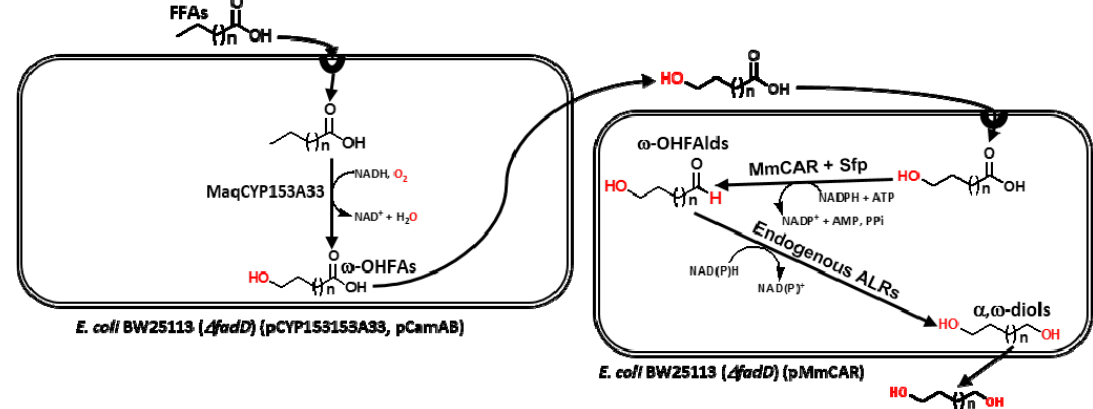
Figure 1. Schematic diagram showing the biosynthesis of medium- to long-chain α , ω -diols (C 8 –C 16 ) from free fatty acids (FFAs). ω -OHFAs, ω -hydroxy fatty acids; ω -OHFAlds, ω -hydroxy fatty aldehydes.